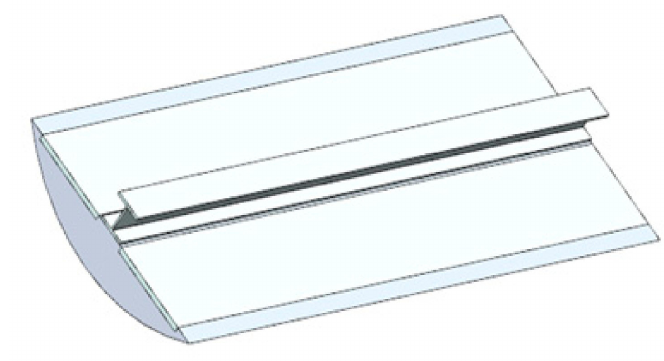
Figure 5. Model of the guideway of the Hyperloop system used in computer